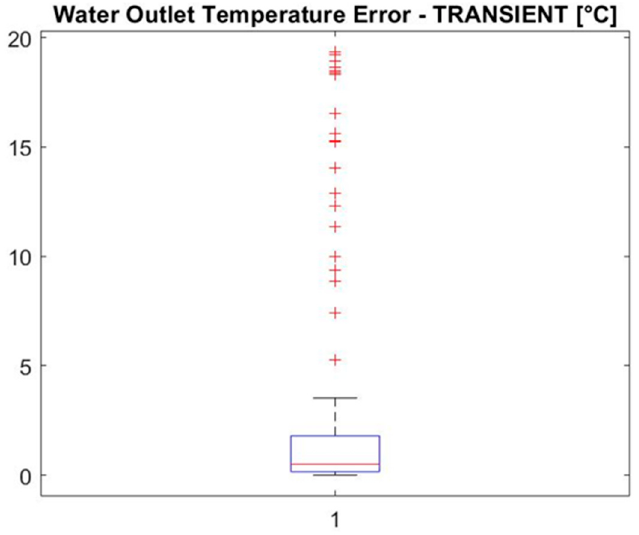
Figure 22. Water outlet temperature (in transient conditions) error blockplot diagram for a number of sections n = 10.